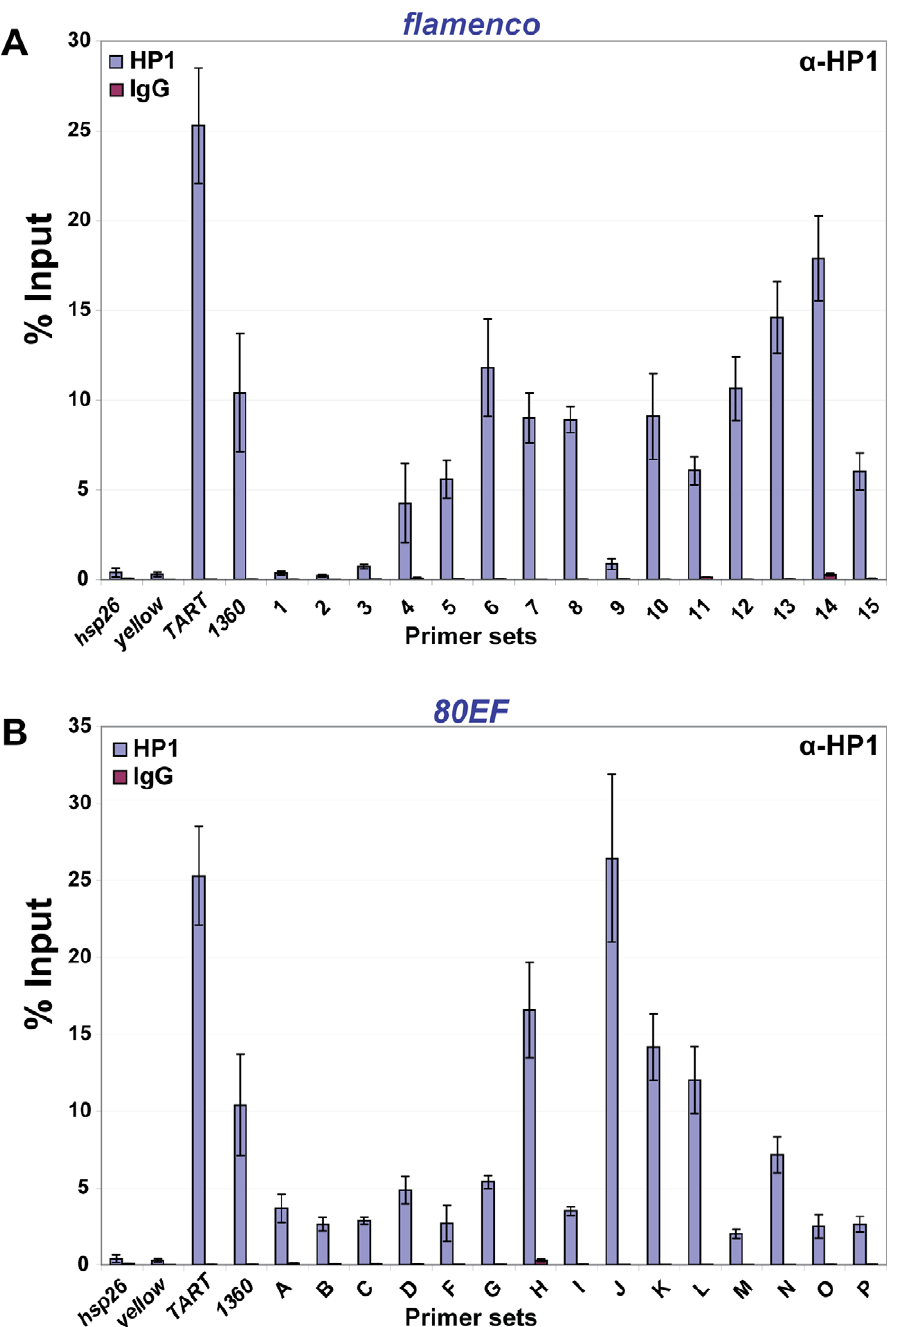
Figure 4. HP1 associates with chromatin at piRNA clusters in ovaries. ChIP at (A) flam and (B) 80EF piRNA clusters in wild type ovaries with antibodies specific to HP1 (blue) and normal rabbit IgG clusters and has a minimal effect on HP1 association with TE chromatin association.